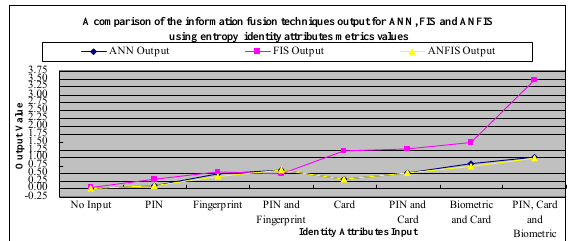
Fig. 8. A comparison of the information fusion techniques output for artificial neural network, fuzzy inference system and adaptive neural-fuzzy inference system using entropy identity attributes metrics